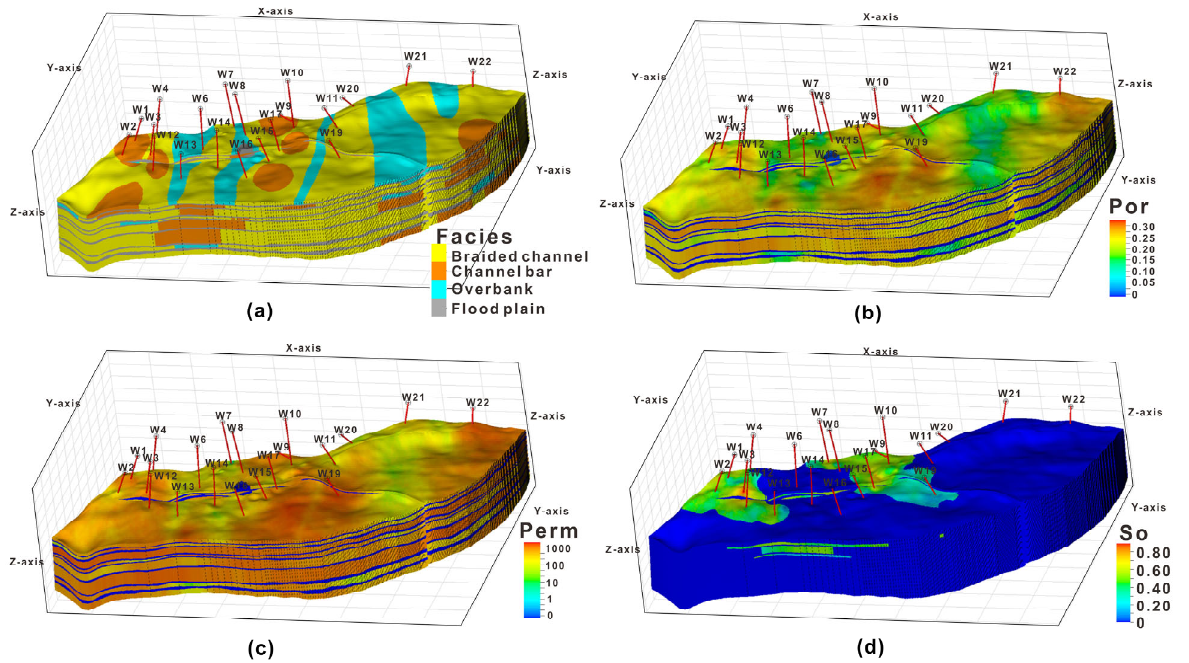
Figure 13. ( a ) Facies model. ( b ) Porosity model. ( c ) Permeability model. ( d ) Water saturation model.